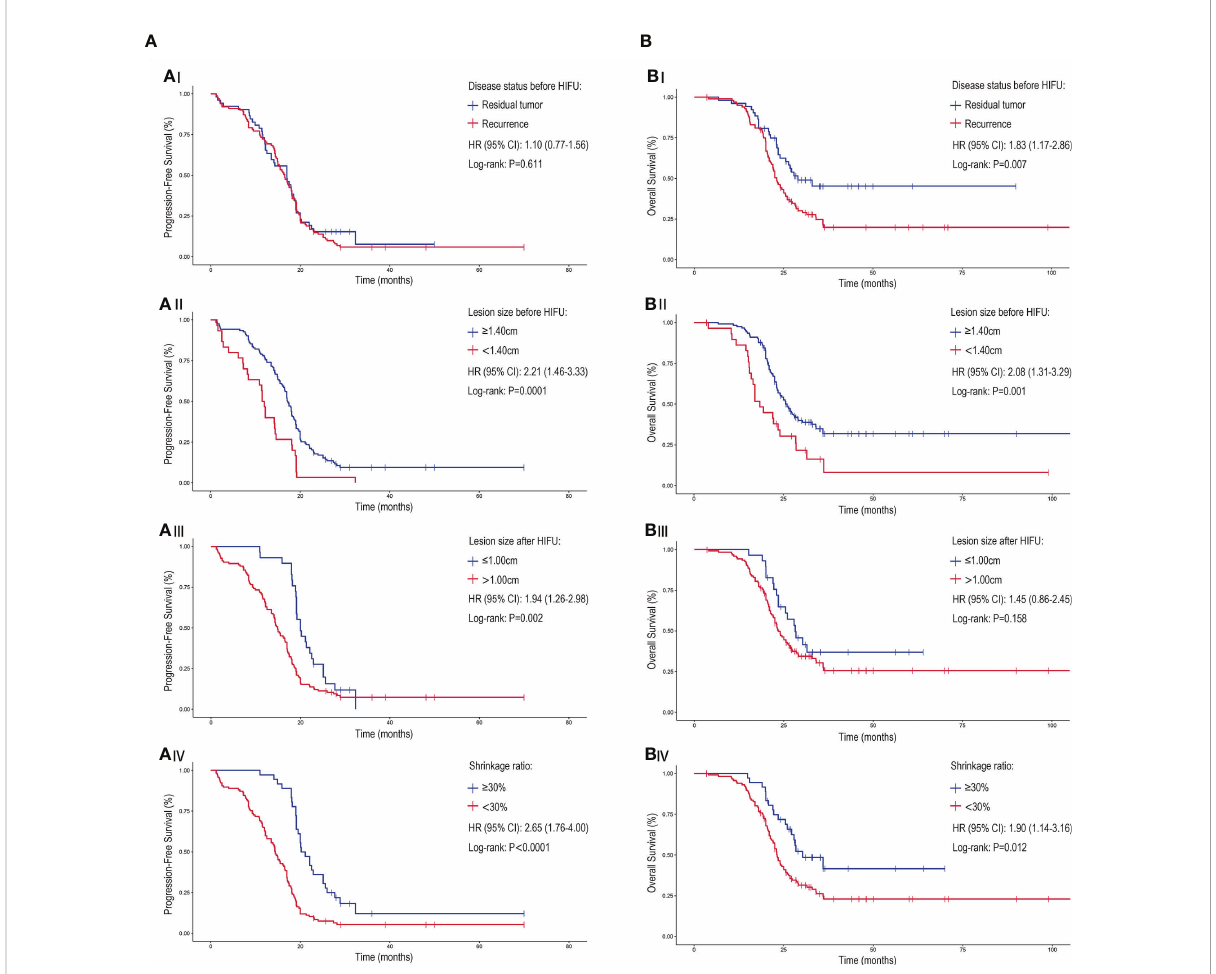
FIGURE 3 The PFS and OS associated with of different disease patterns and lesion characteristics for cervical patients treated with HIFU. The (A) PFS and (B) OS of cervical cancer patients treated with HIFU. (A/BI) The response to HIFU for previously irradiated patients that experienced residual disease compared to recurrence. Patient outcome when strati fi ed for (A/BII) lesion size prior to HIFU treatment, (A/BIII) lesion size after HIFU treatment and (A/BIV) lesion shrinkage ratio (comparing the lesion size change before and after HIFU treatment). Crosses were used to denote censored patients. Hazard ratio (HR), con fi dence interval